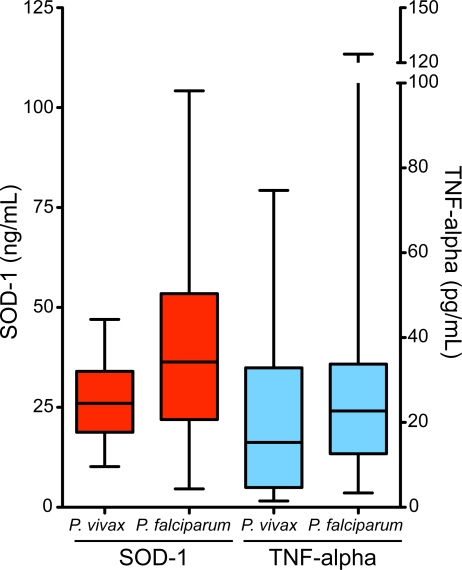
Plasma concentrations of SOD-1 and TNF-alpha during P. vivax and P. falciparum infections.Plasma levels of SOD-1 (red boxes) and TNF-alpha (blue boxes) were measured in patients with mild P. vivax (n = 50) or mild P. falciparum (n = 16) malaria. Boxes represent median and interquartile interval; whiskers represent maximum and minimum values. The differences between P. vivax and P. falciparum infections were not significant when compared by the Mann-Whitney test (p>0.05).